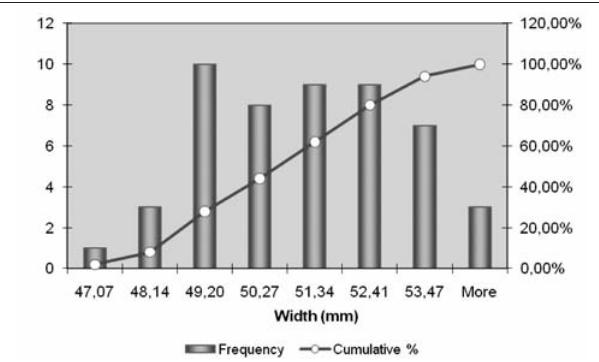
Fig. 17: Distribution of the width values of category AAA of Hungarian apricot